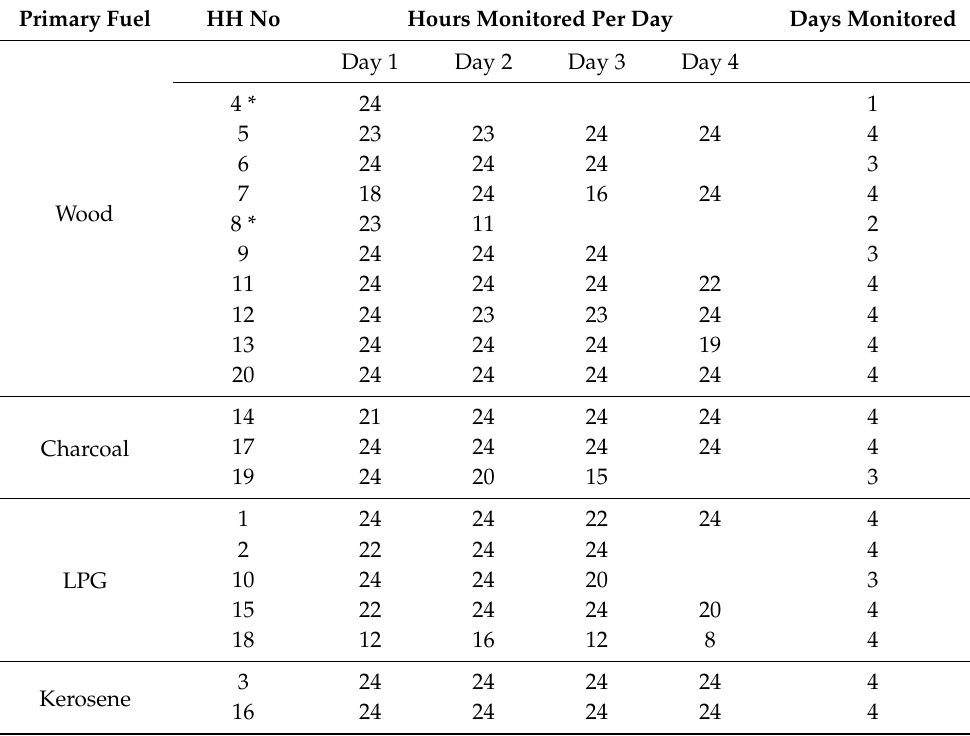
Table A2. Hours per day when particulate matter monitoring was done in different